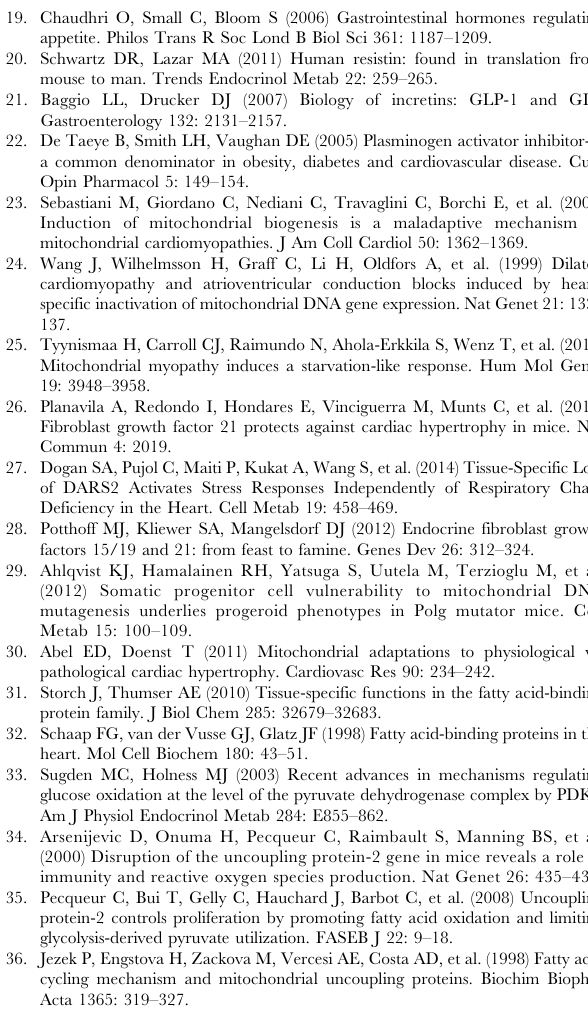
Figure S5 Expression analysis of genes involved in glycolysis and fatty acid oxidation-related genes. (A) Relative expression levels of lipolytic and FAO-related genes: Acot10 - acyl- Coenzyme A